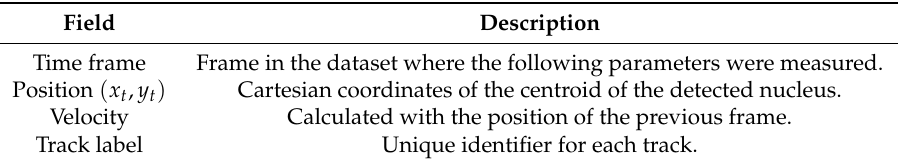
Table 1. Brief description of the main parameters measured per track.